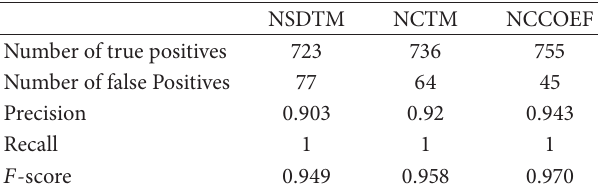
Table 3: Performance of breast detection classifier.